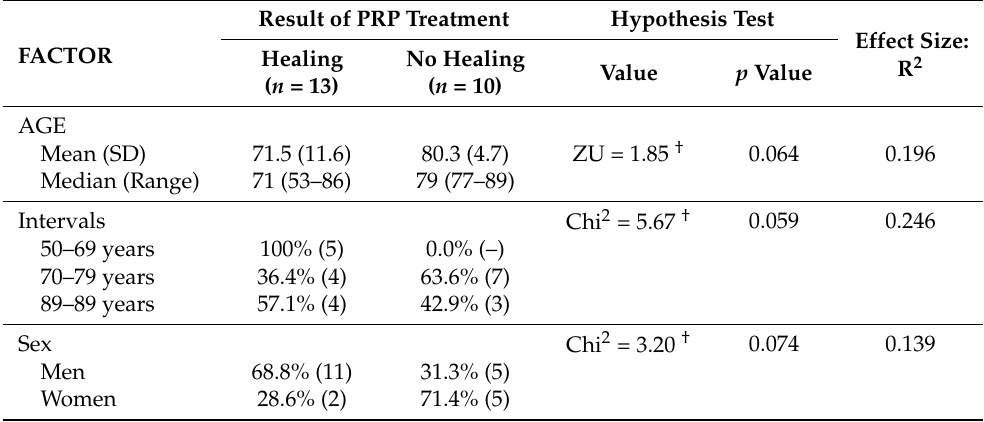
Table 2. Sociodemographic factors associated with wound healing in patients treated with PRP ( N = 23 CNHWs).